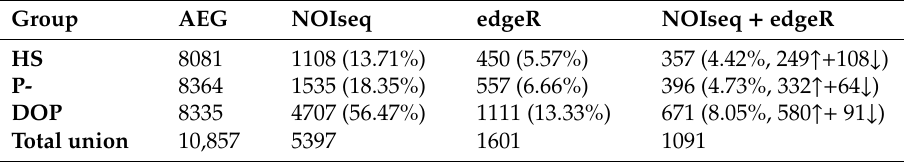
Table 2. Number of DEGs under di ff erent conditions identified by NOIseq and